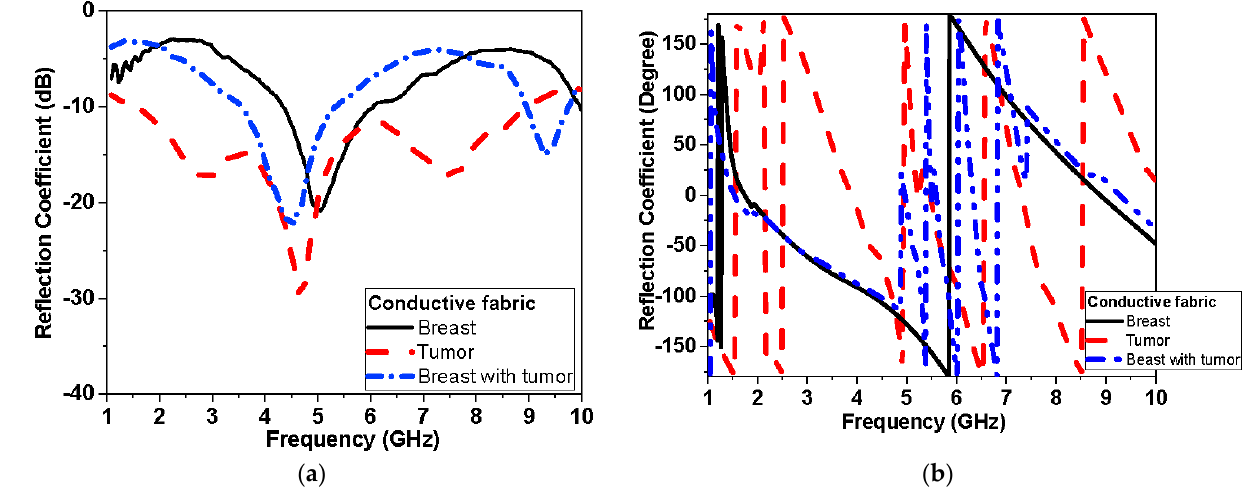
Figure 19. Measured |S 11 | of conductive fabric antenna performance with breast phantom and tumor: ( a ) magnitude and ( b ) phase.